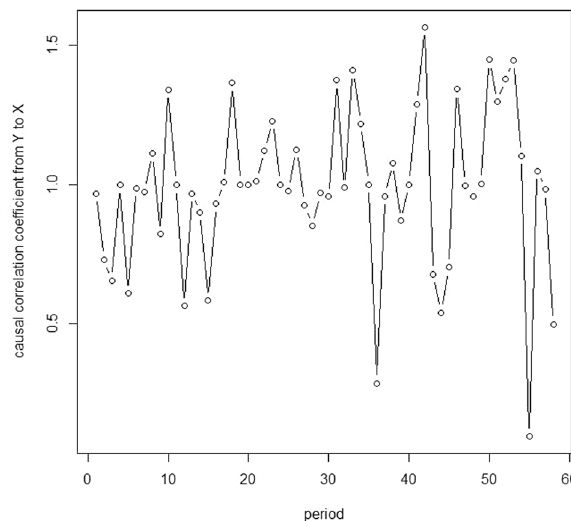
Fig. 4 Hausdorff minimal distances between optimal empirical and absolute causal relations. The solid line stands for the absolute causal relations from MHP (or X) to MSP (or Y), while the dashed line stands for the absolute causal relations rom MSP (or Y) to MHP (or